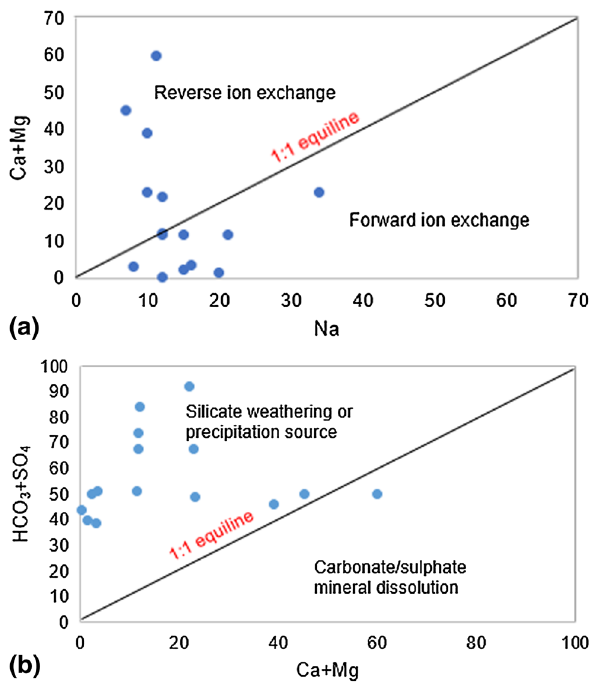
Fig. 10 Scatter plots for: a Na versus (Ca + Mg) (mg/L), b (Ca + Mg) versus (HCO 3 + SO 4 )